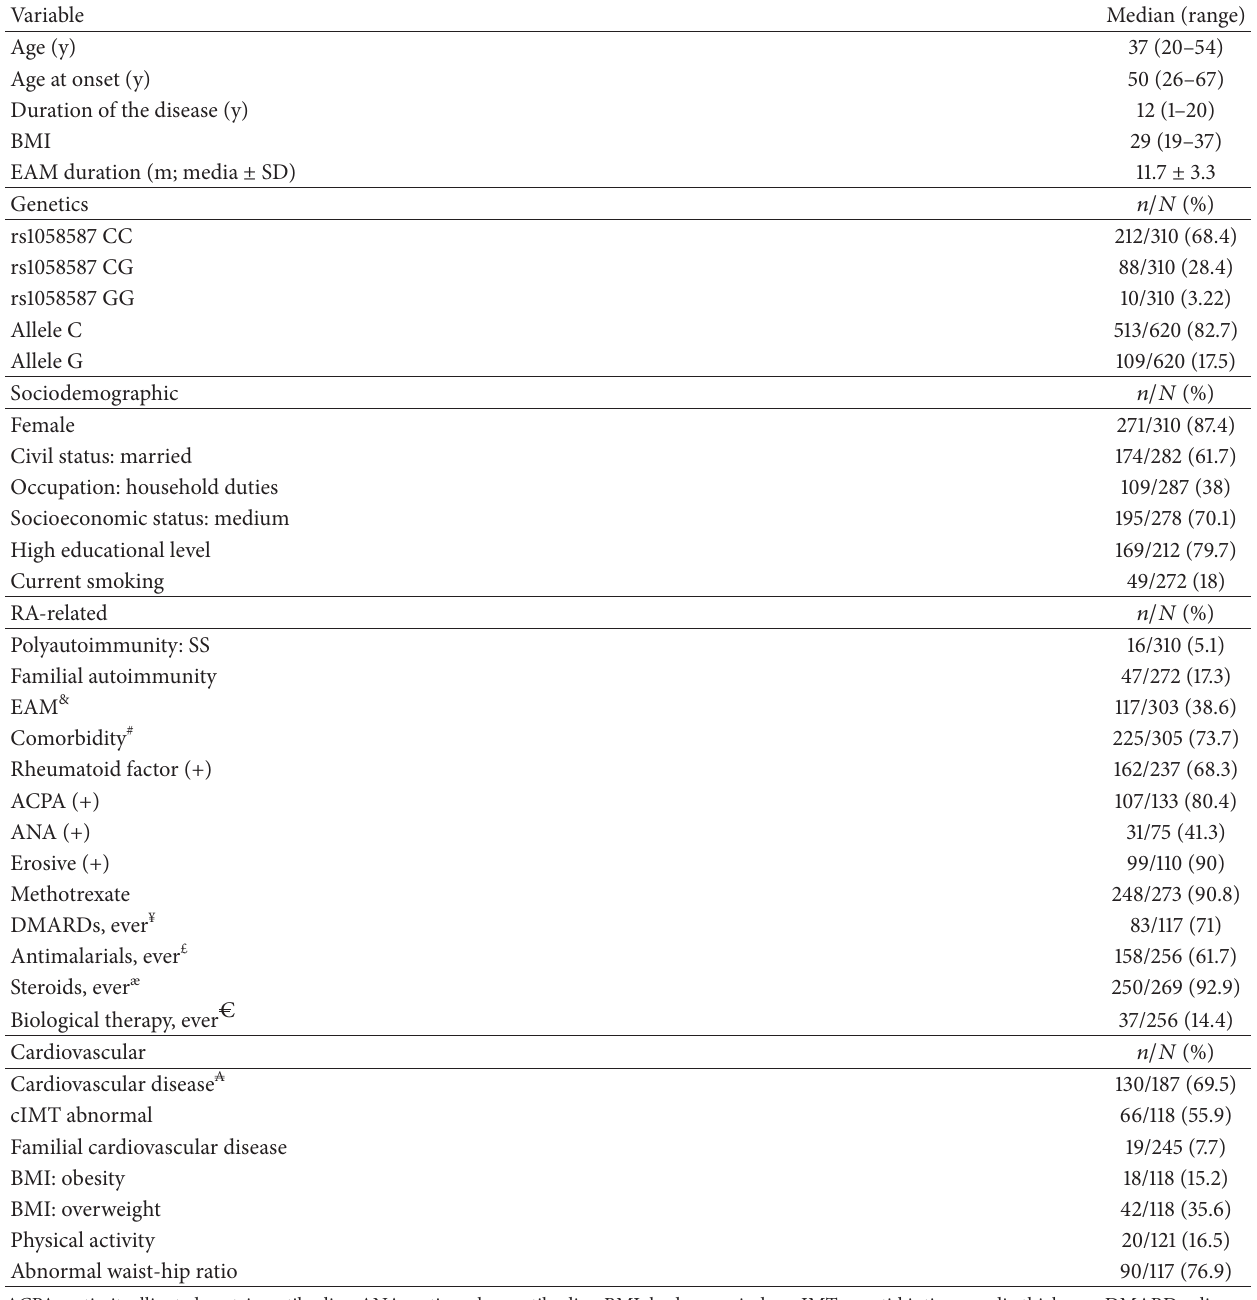
Table 1: Demographic and clinical characteristics of 310 patients with